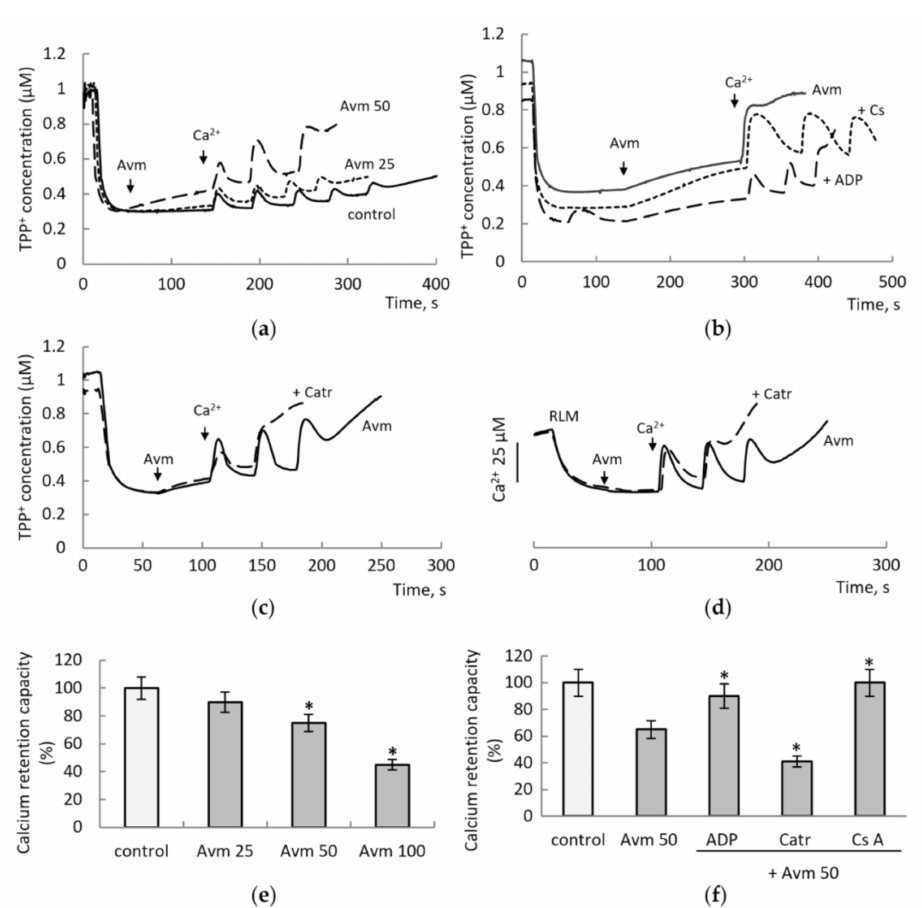
Figure 3. Influence of avermectin on MPTP opening induced by calcium ions. MPTP opening in the course of successive additions of 25 µ M CaCl2 determined by a drop of the membrane potential in the presence of avermectin (Avm) at a concentration of 25 and 50 ( a ); the influence of ADP (25 µ M) and cyclosporin A (Cs, 2 µ M) in the presence of 100 µ M avermectin on the membrane potential drop ( b ); the influence of carboxyatractyloside (Catr, 2 µ M) in the presence of 50 µ M avermectin on the membrane potential drop ( c ) and calcium release ( d ); changes of the calcium retention capacity at different concentrations of avermectin ( e ) and in the presence ADP, Catr and Cs ( f ). The value of control calcium retention capacity (100%) is equal 110+12 µ M at a concentration of mitochondrial protein of 1 mg. Asterisk (*) indicates values that differ significantly from the control values ( p <